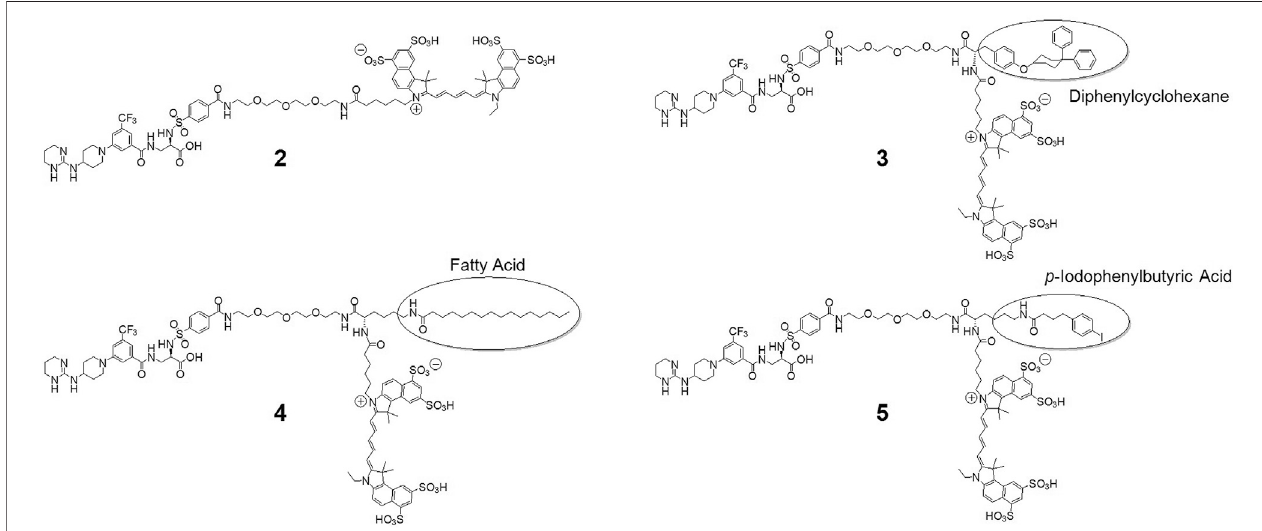
FIGURE1| Structuresofthedevelopedandinvestigatedprobes.Derivedfromtheoriginalprobe 2 ,wemodi fi edthemainstructurewithaminoacidlinkers(tyrosine and lysine, respectively) to mount albumin binding moieties diphenylcyclohexane to yield 3 , palmitic acid for 4 and p -iodophenylbutyric acid for compound 5 . Finally, all probes were labelled with cyanine dye Cy 5.5.